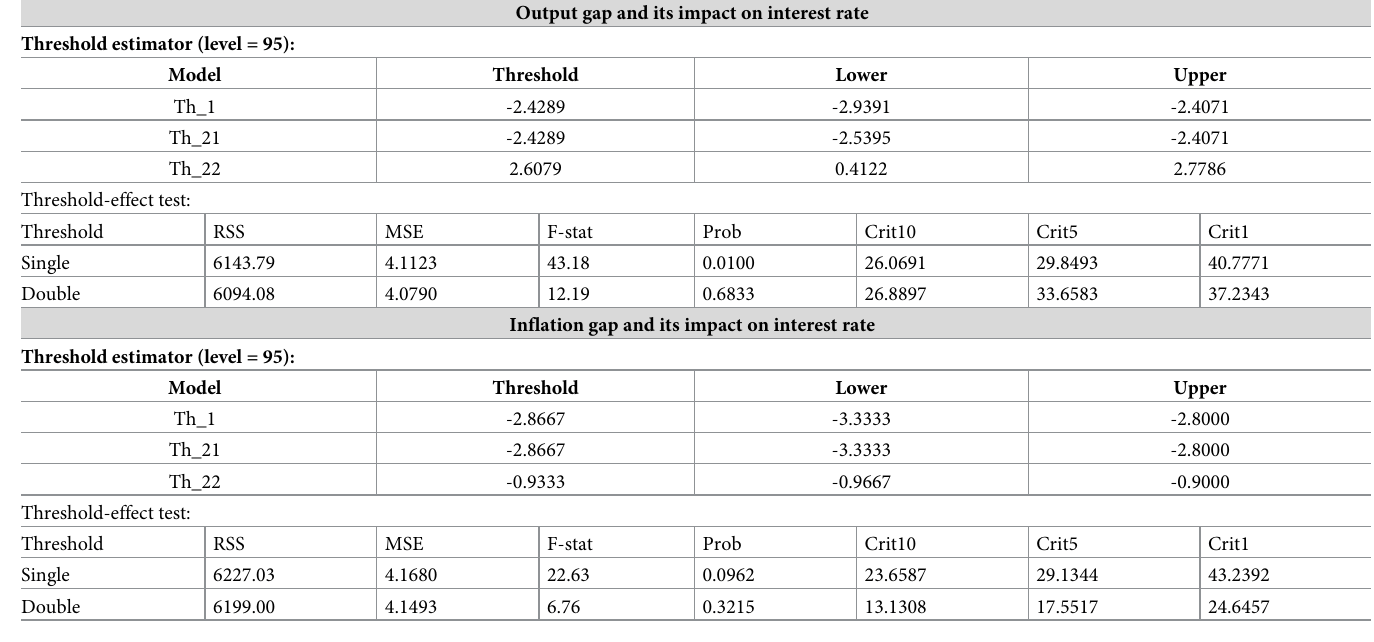
Table 3. Multiple-threshold models of each explanatory variable and its impact on interest rate. Output gap and its impact on interest